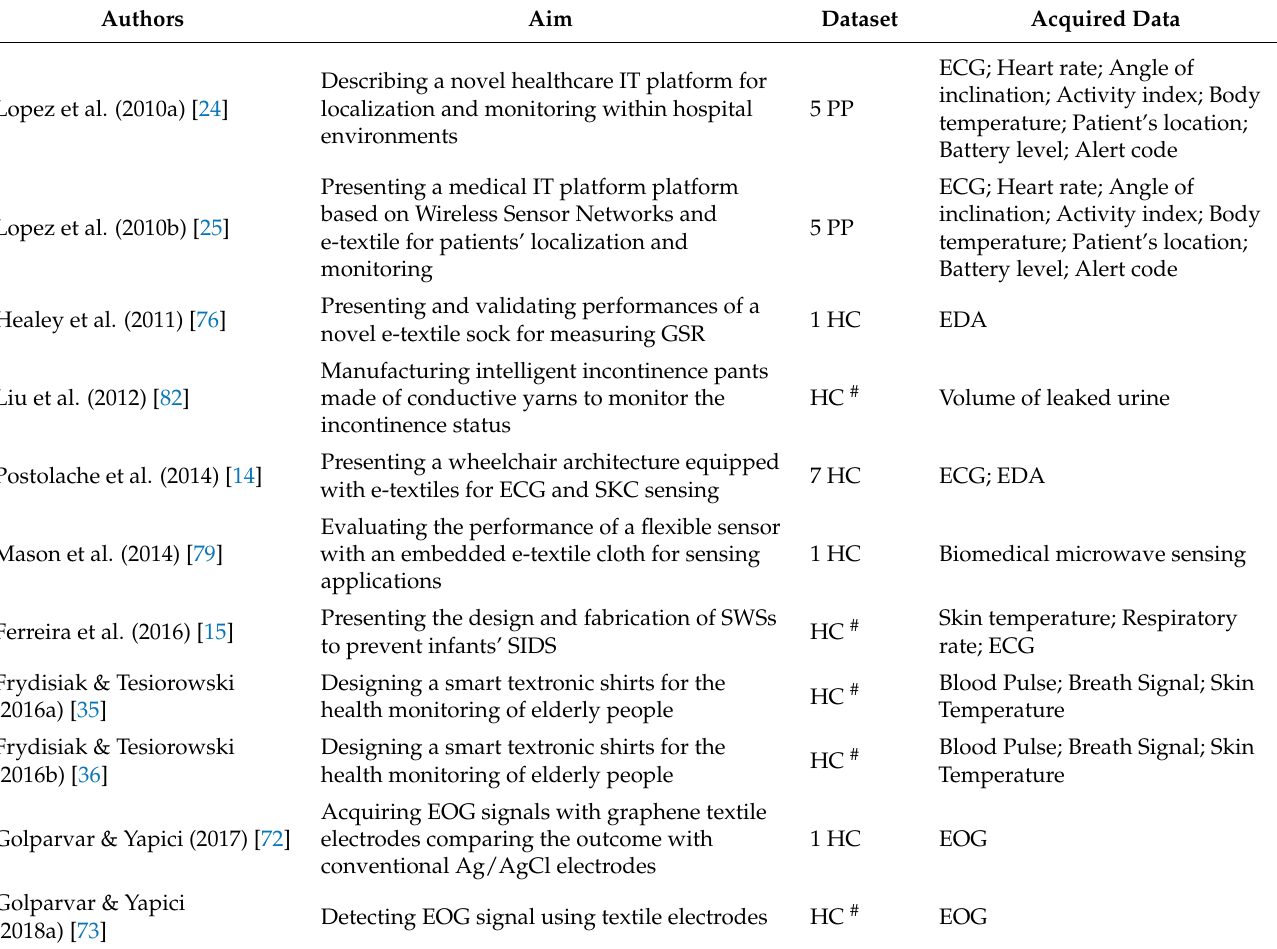
Table 6. Insights regarding e-textile literature in other fields: authors, aim, dataset, and data.